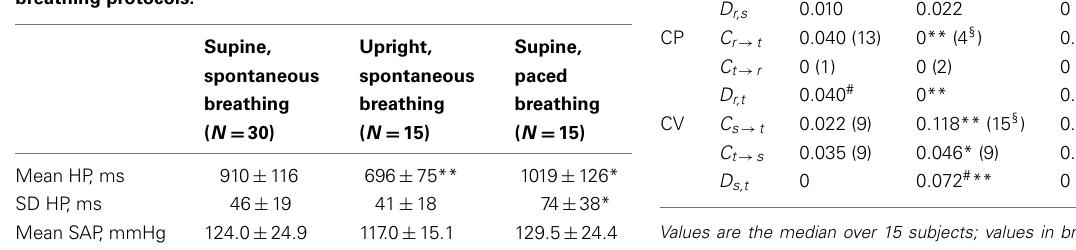
Values are the median over 15 subjects; values in brackets are the number of subjects (out of 15) for which non-zero causal coupling was found. *p < 0.05, **p < 0.005 up vs. su and sp vs. pa (paired test); # p < 0.005, directionality index D is different from zero (paired test); § p < 0.05, su vs. up or sp vs. pa (proportion